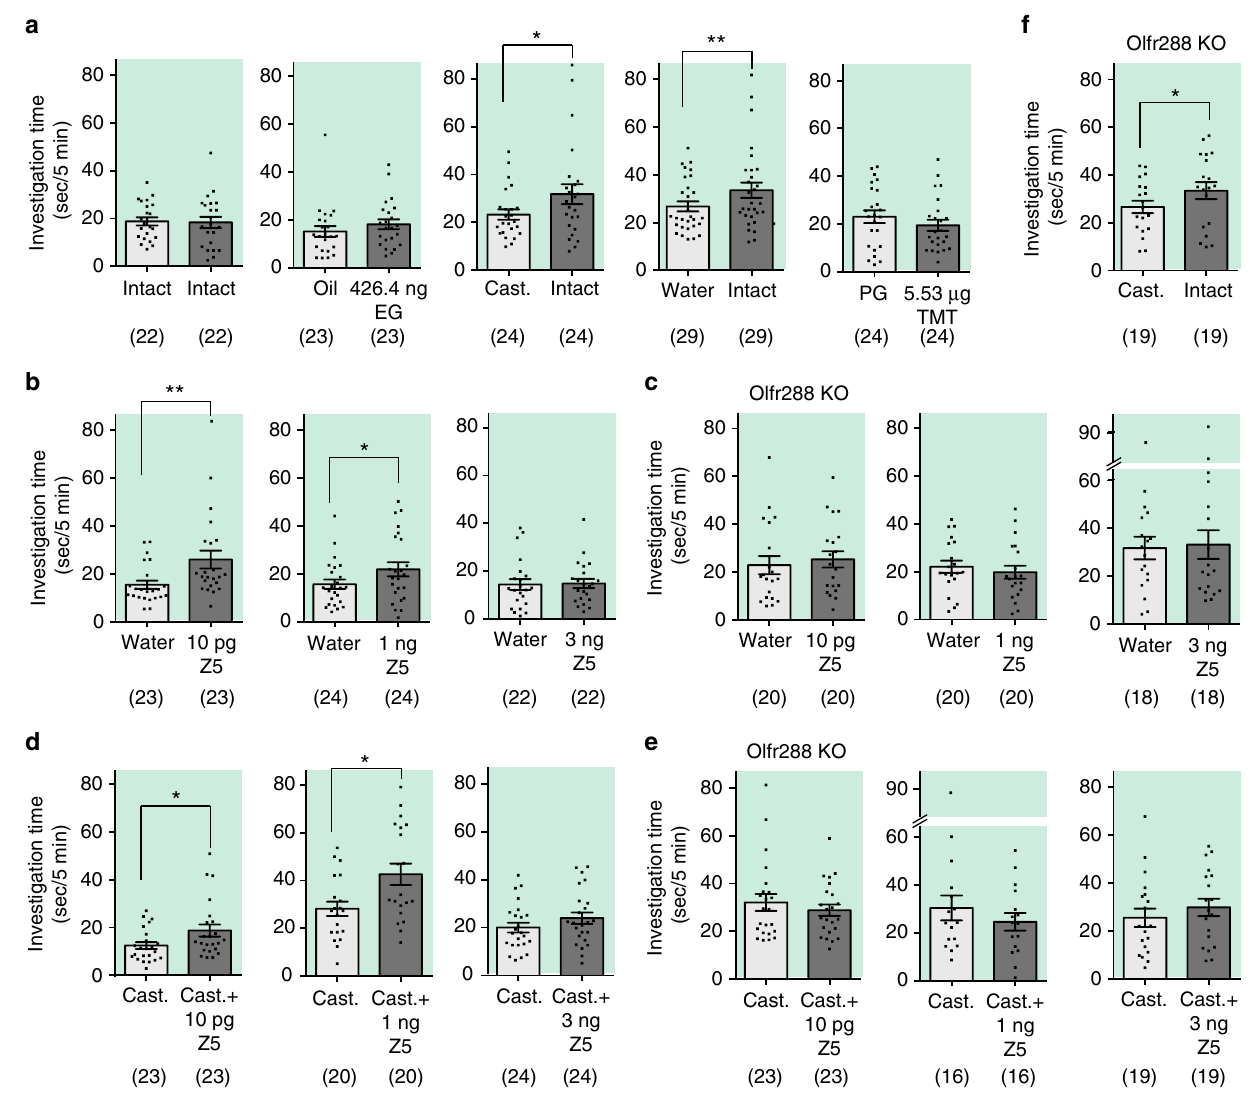
Fig. 3 Attraction to Z5 – 14:OH is diminished in Olfr288 knockout mice. a Series of control experiments in the two-choice odor-preference test. Intact: urine from intact male C57BL/6 mice; Cast.: urine from castrated male C57BL/6 mice. TMT was diluted in PG. Oil: mineral oil; EG: eugenol. b , c Attraction to various amounts of Z5 – 14:OH of adult female C57BL/6 mice ( N = 22 – 24) ( b ) and adult female Olfr288-KO mice ( N = 18 – 20) ( c ). Z5: Z5 – 14:OH. d , e Preference for castrated male urine, with or without various amounts of Z5 – 14:OH, of adult female C57BL/6 mice ( N = 20 – 24) ( d ) and adult female Olfr288-KO mice ( N = 16 – 23) ( e ). f Preference for intact male urine vs. castrated male urine in adult female Olfr288-KO mice ( N = 19). Bars indicate the mean time that a mouse spent investigating each test sample within a 3-min period, ±S.E.M. ( N = 16 – 29). Asterisks indicate signi fi cant difference between two samples (paired Student ’ s t -test, * P < 0.05, ** P <